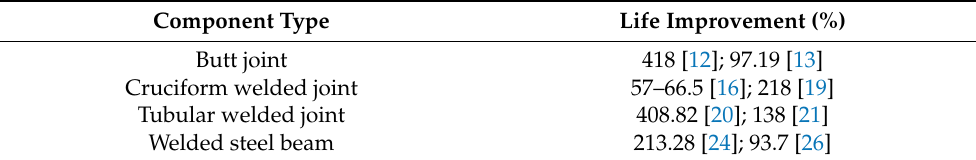
Table 1. Fatigue performance improvement percentage of welded joint reinforced by